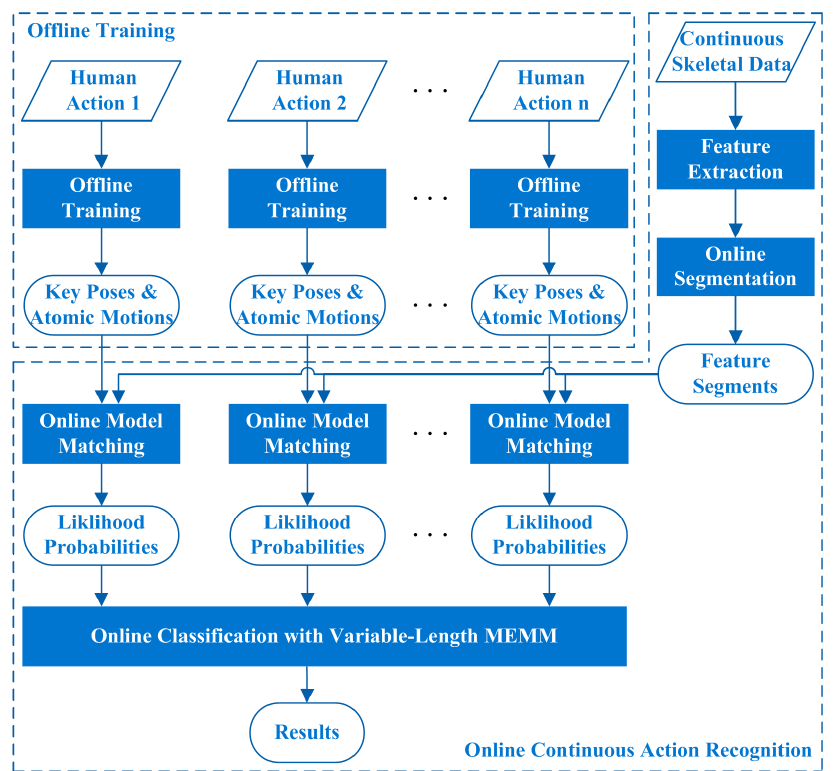
Figure 6. The outline of the proposed algorithm.